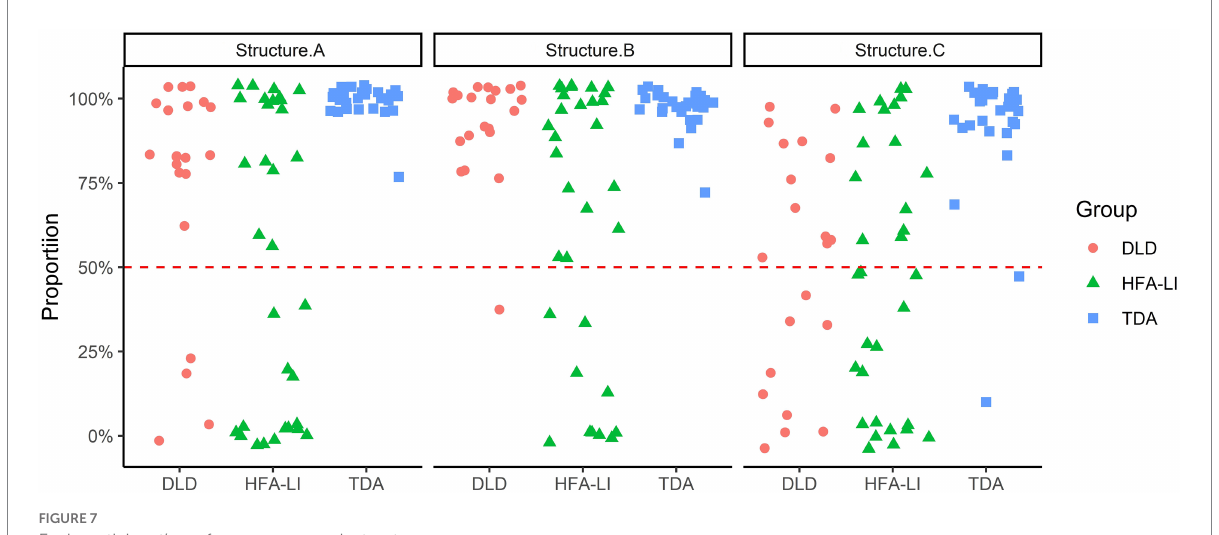
FIGURE 7 Each participant’s performance on each